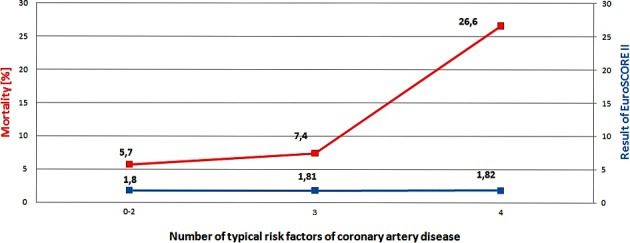
Relation between results of EuroSCORE II, mortality and number of typical risk factors of coronary artery disease.Out of BMI ≥ 25 kg/m2, hypertension, hyperlipidemia, diabetes.